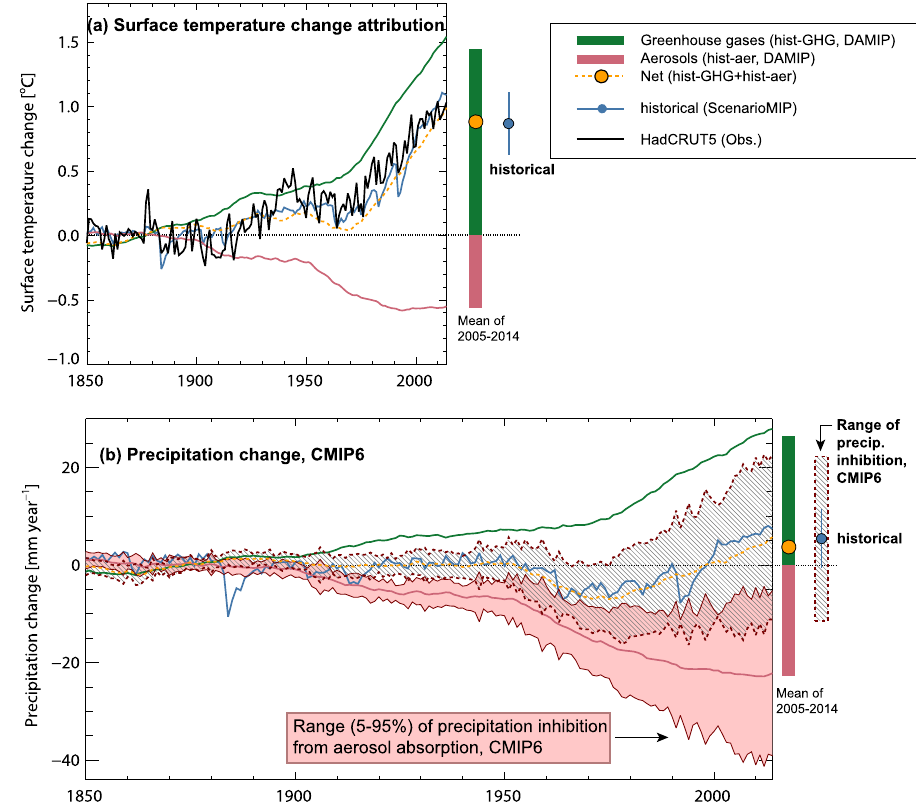
Fig. 4 Aerosol-induced absorption makes up a dominating source of uncertainty in simulated historical precipitation change. a The contributions of well-mixed greenhouse gases (green) and aerosols (red) to historical surface temperature change, from DAMIP simulations, compared to CMIP6 historical simulations (blue) and HadCRUT5 surface temperature observations (black). The yellow dashed line shows the net contribution from greenhouse gases and aerosols. Bars and dots show the mean over 2005 – 2014. b As a , but for precipitation. The red band shows the 5 – 95% range of precipitation inhibition diagnosed from the CMIP6 multi-model spread in anthropogenic absorbing aerosol optical depth. The grey shaded band shows the same range, shifted to lie around the precipitation change from CMIP6 historical all-forcing